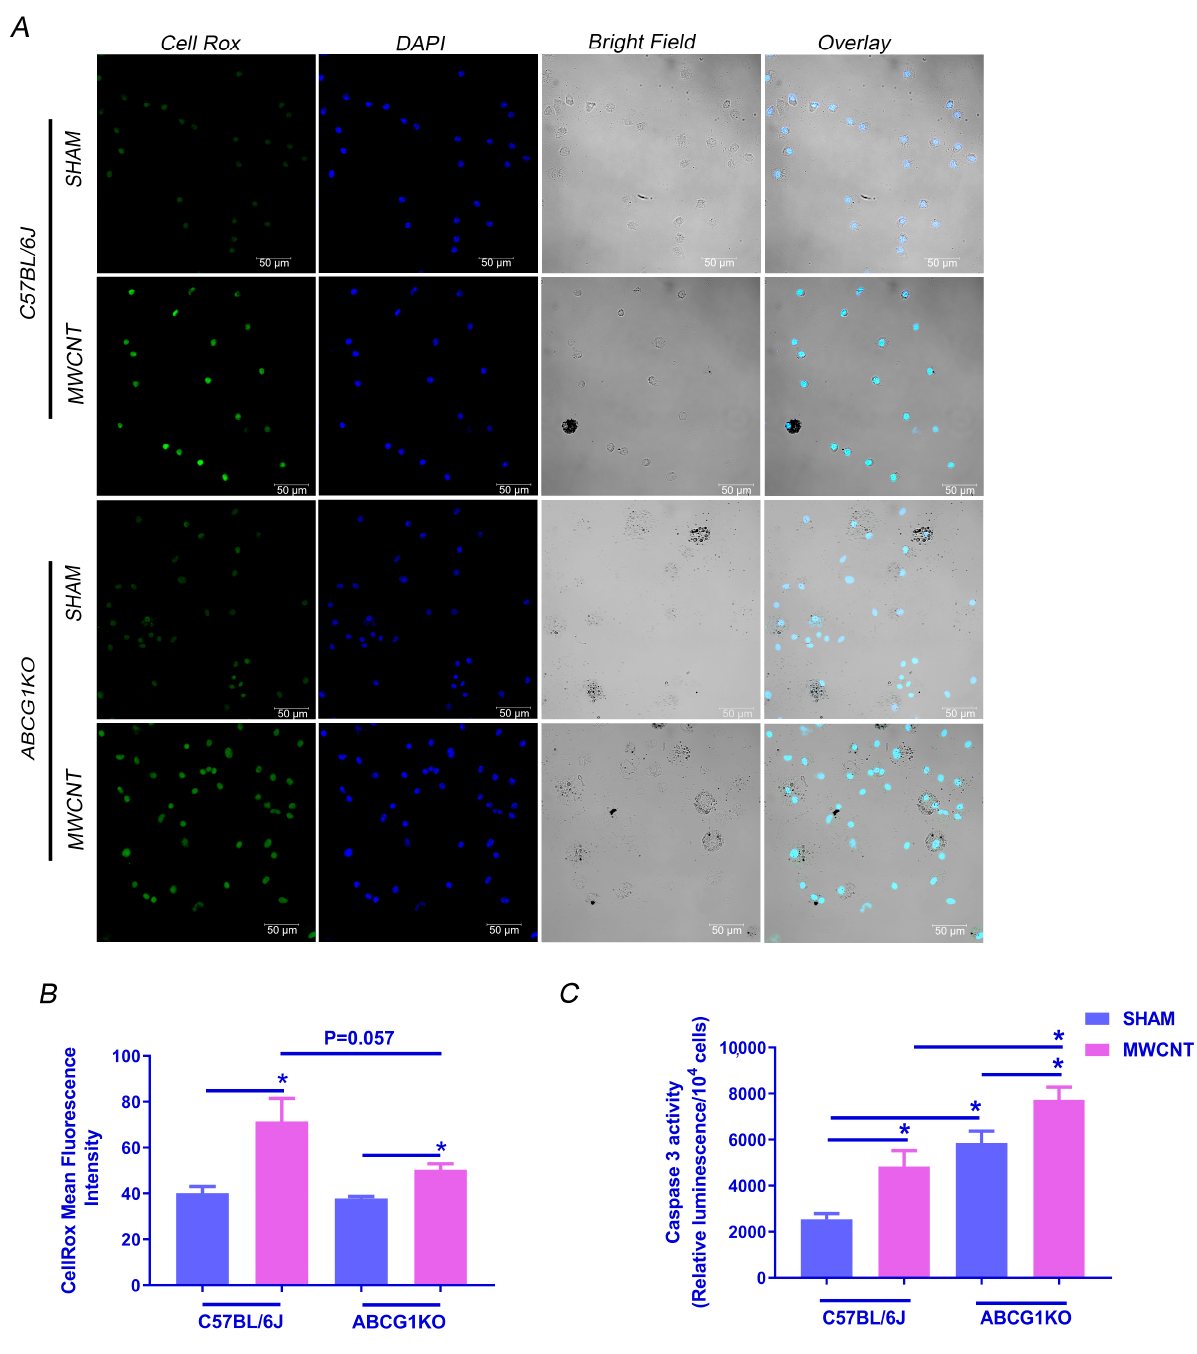
showing an increase in fibrosis in lung sections of MWCNT instilled ABCG1 KO mice using trichrome staining. Scale bars: 50 µ m. ( D , E ) Measurement of IL-13 and smad-3 mRNA expression, respectively, in BAL cells using qRT-PCR (* p ≤ 0.05, N ≥ 3).